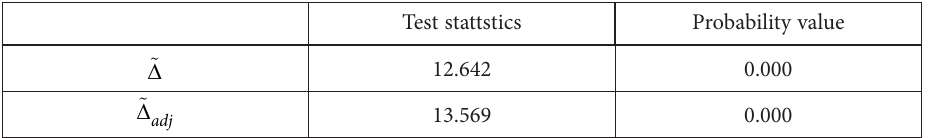
Table 4. Slope of homogeneity test (source: own processing)